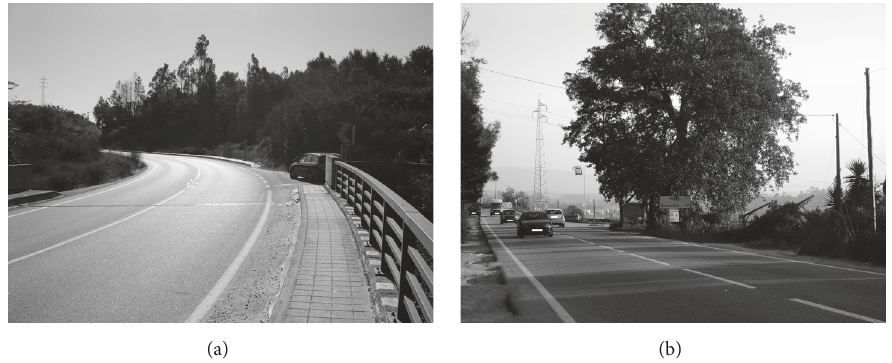
Figure 1: Examples of the considered roads: N 101 (a) and N 206